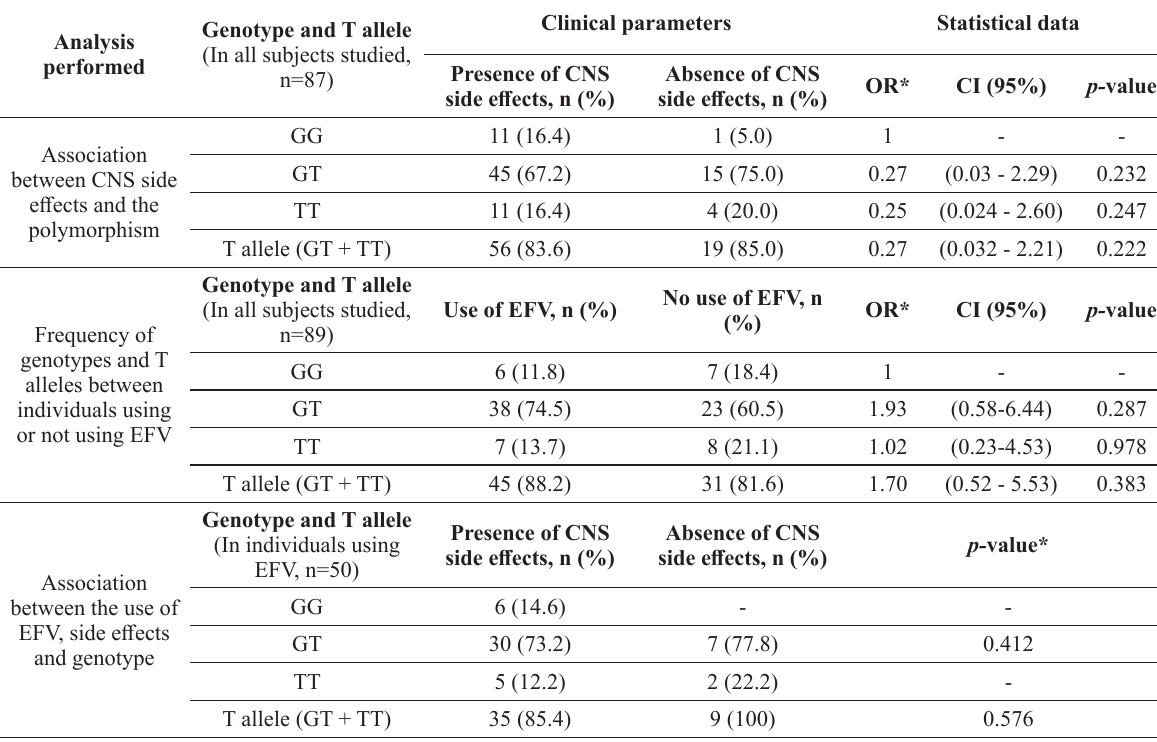
Influence of CYP2B6 516 G>T genotypes on the presence or absence of CNS side effects in EFV patients. Genotype and T allele Analysis (In all subjects performed